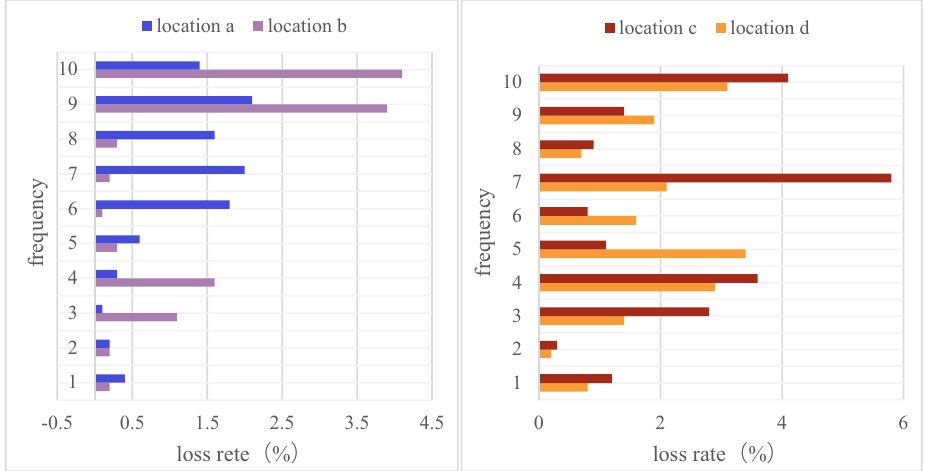
Figure 10: Eavesdropping packet loss